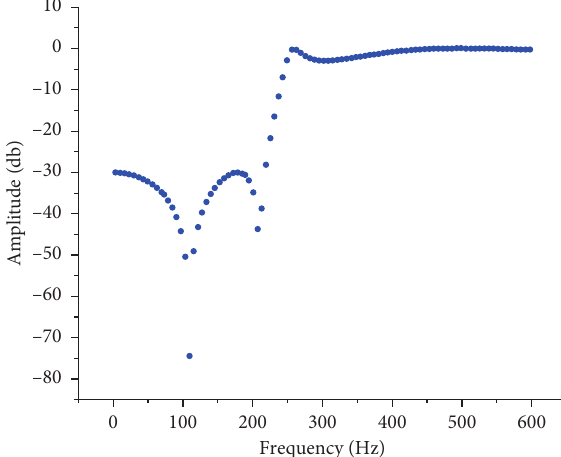
Figure 10: The spectrum of high-pass filter applied to recorded signal. The cutoff area lies between 200 and 300Hz. The filter is characterized by two lobes in the area below 200Hz, and the flatness of the filtering over 300 Hz is